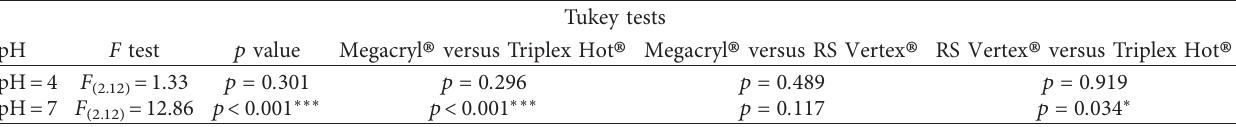
Figure 20: Time and average strength applied until fracture in three different acrylic resin brands by pH. Table 3: One-way ANOVA test for comparison of the three pH-separated acrylic resin brands.